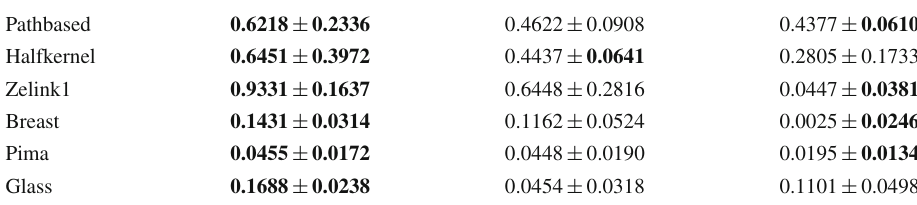
Table 9 Sensitivity analysis of ARI indicator when p ={1-8}